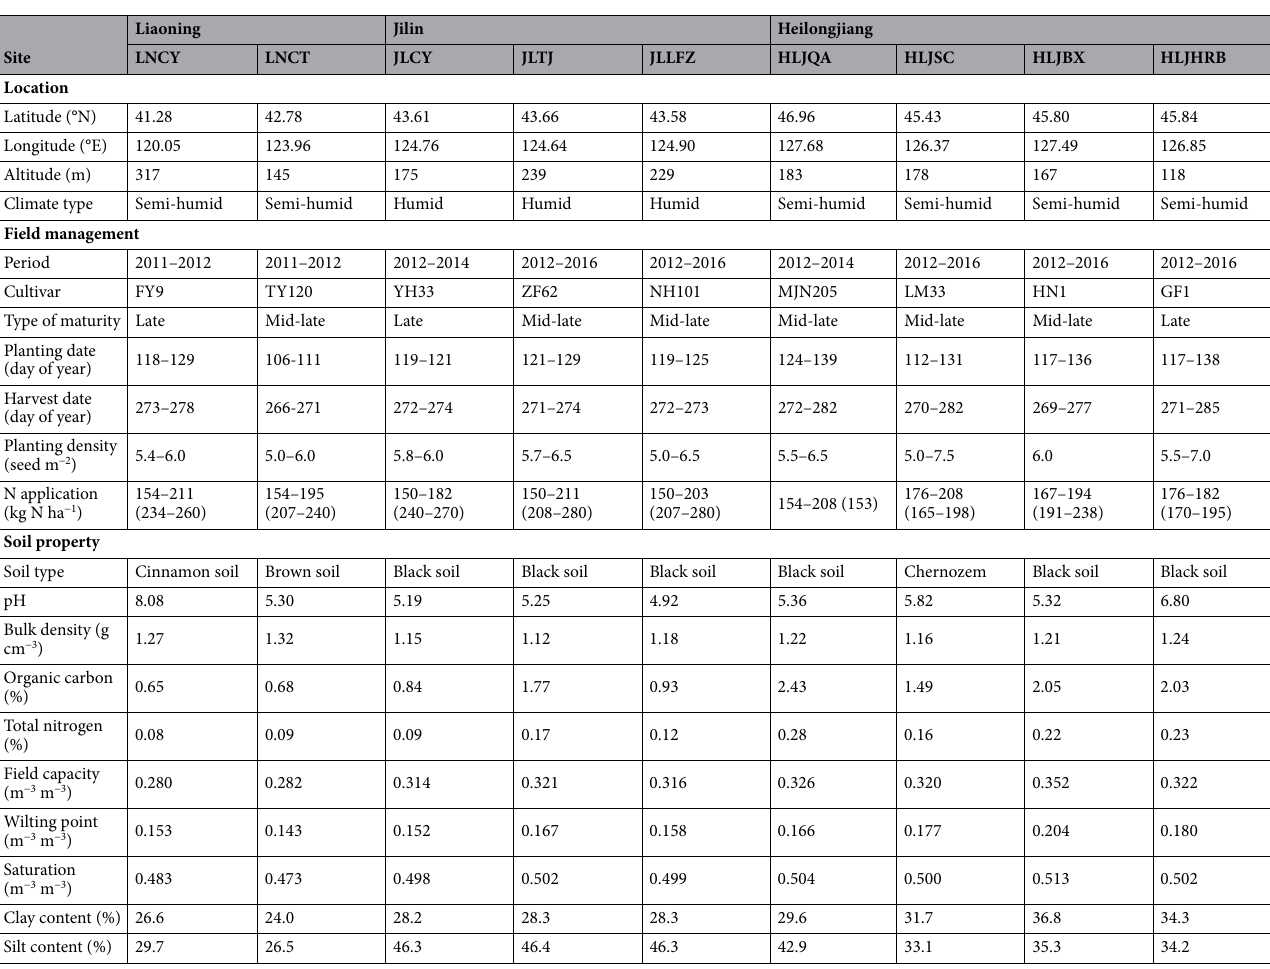
Table 3. Field management practices and soil properties (0–0.2 m) for maize study sites from 2011 to 2016 at Liaoning (LN), Jilin (JL) and Heilongjiang (HLJ) provinces in Northeast China. LNCY,